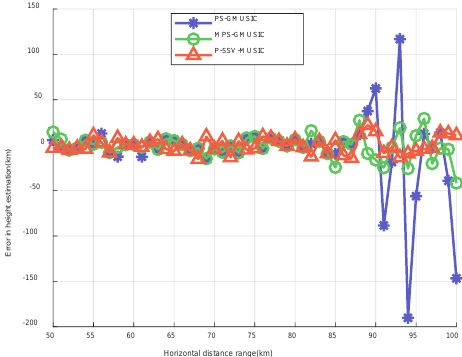
Figure 12. Error results of target height measurement.